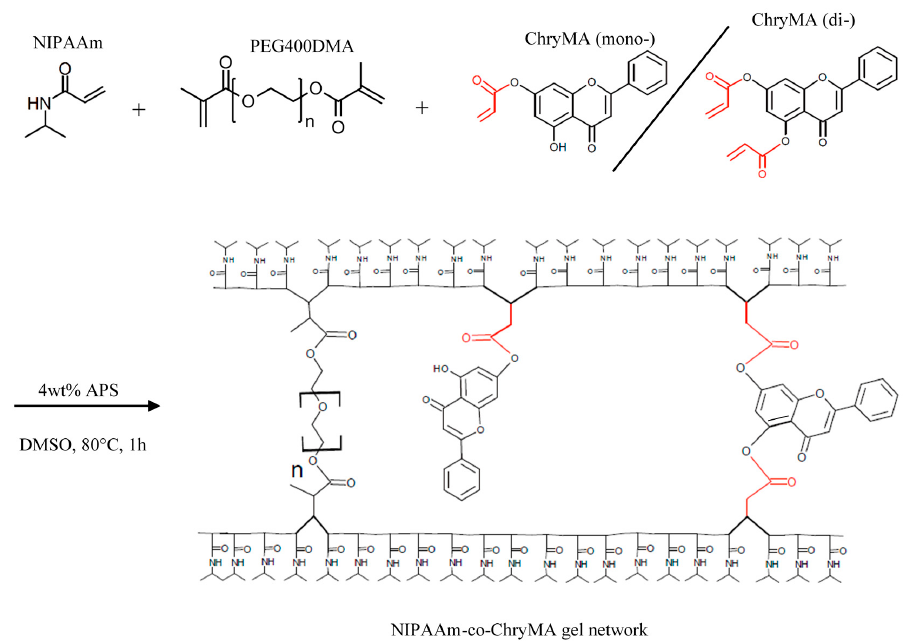
Figure 3. Example polymerization scheme for synthesizing N -isopropylacrylamide (NIPAAm)- co - ChryMA gels.